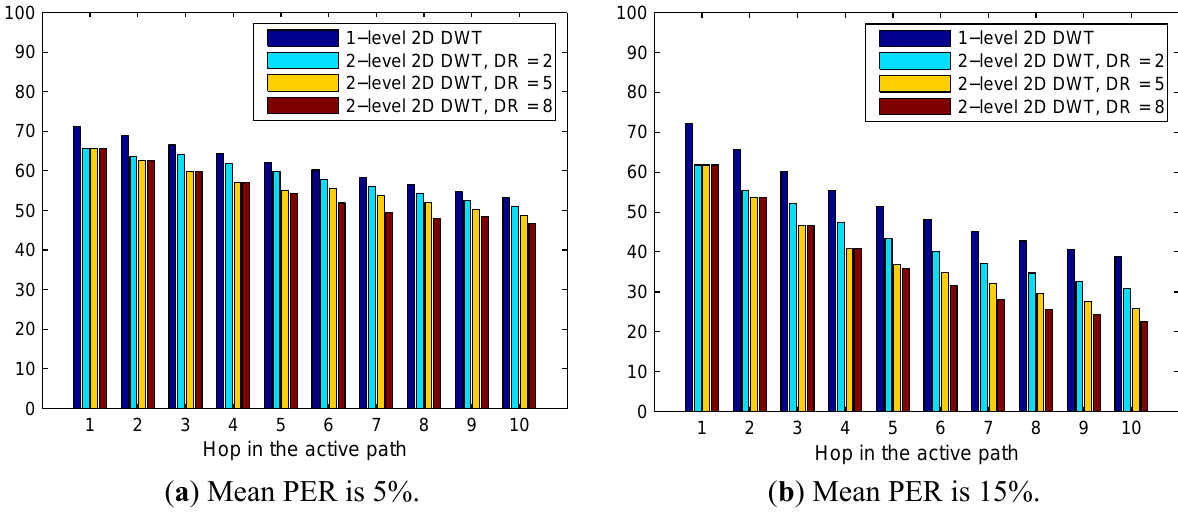
Figure 7. Energy consumption in each intermediate